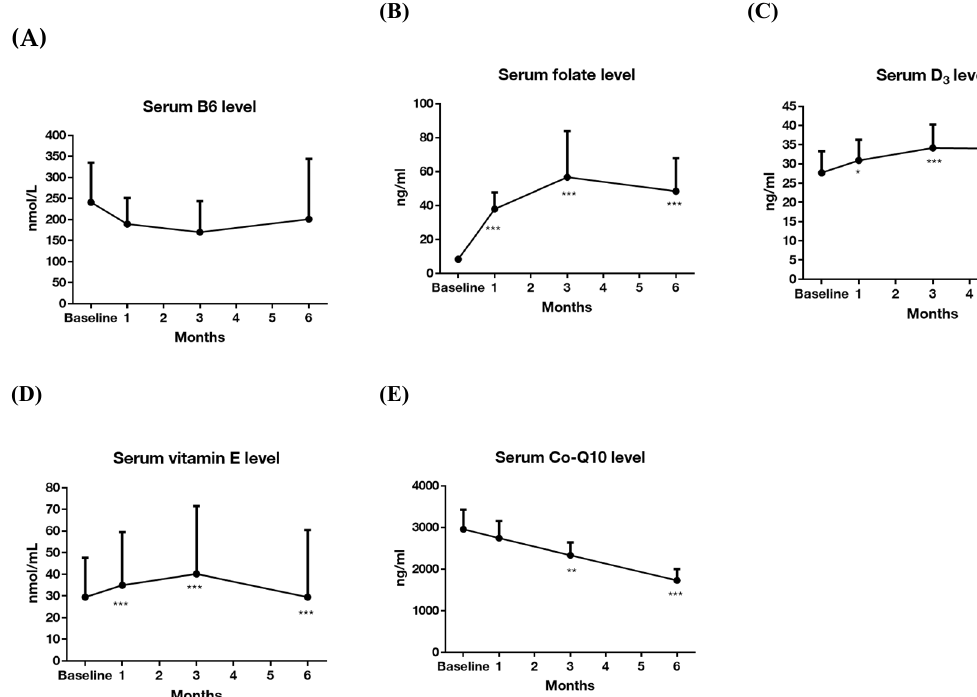
Figure 2. Changes in vitamin levels in the 6-month trial ( n = 26). ( A ) Serum level of vitamin B6; ( B ) serum level of folate; ( C ) serum level of vitamin D3; ( D ) serum level of vitamin E; ( E ) serum level of coenzyme Q10. Data are presented as mean ± 95% confidence interval (above). Y-axis represents vitamin serum levels, and x-axis displays time (by month). Significance was calculated using generalized estimating equation analysis, comparing baseline and after vitamin supplementations. * p < 0.05, ** p < 0.01, *** p < 0.001. Table 3. The vitamin levels at baseline and after six-month supplementation in responders. After 6 Months of Baseline Characteristics